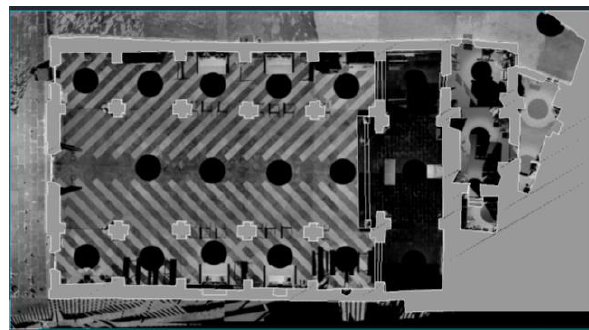
Figure 1 . Map of the Church of San